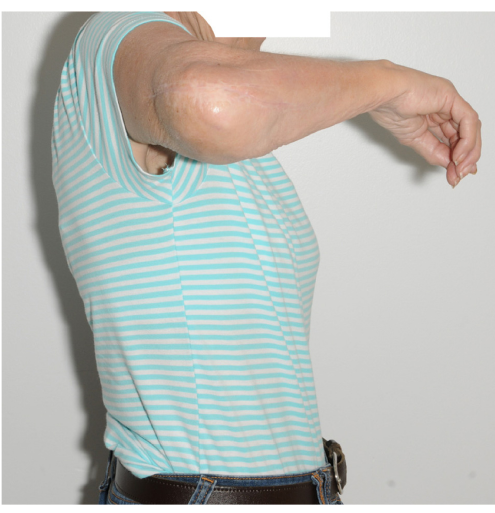
Figure 9. A side view clinical photograph of the third case showing active shoulder lateral abduction.